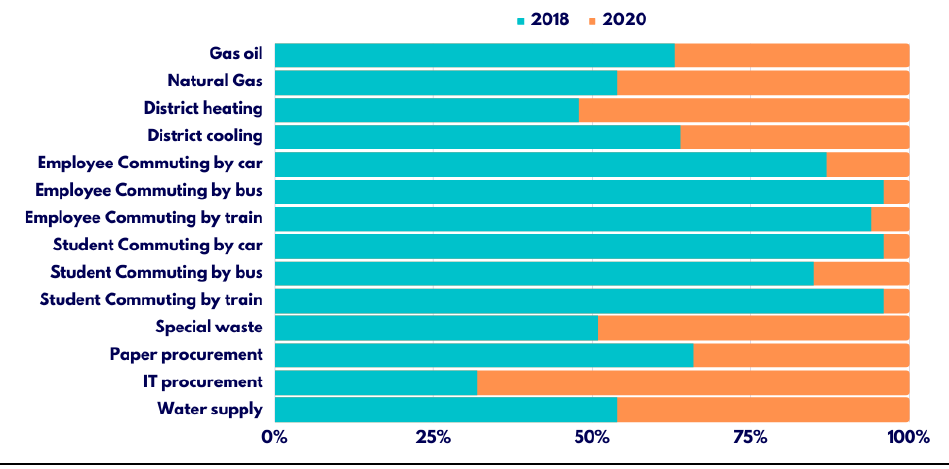
Figure 6. Comparison of 2018 and 2020 emissions by sub activity.